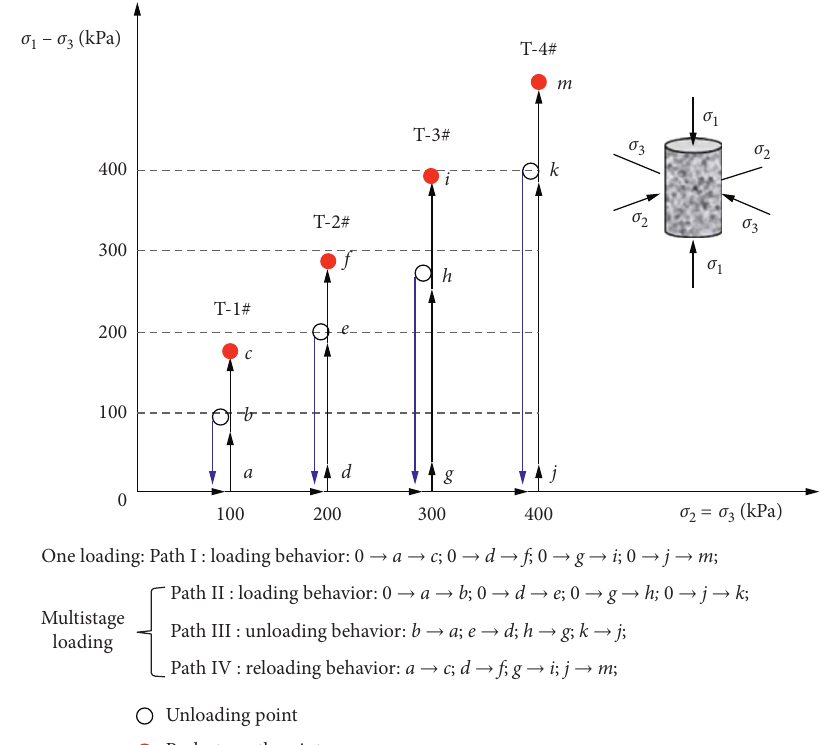
Figure 3: Schematic diagram of the stress paths applied in this